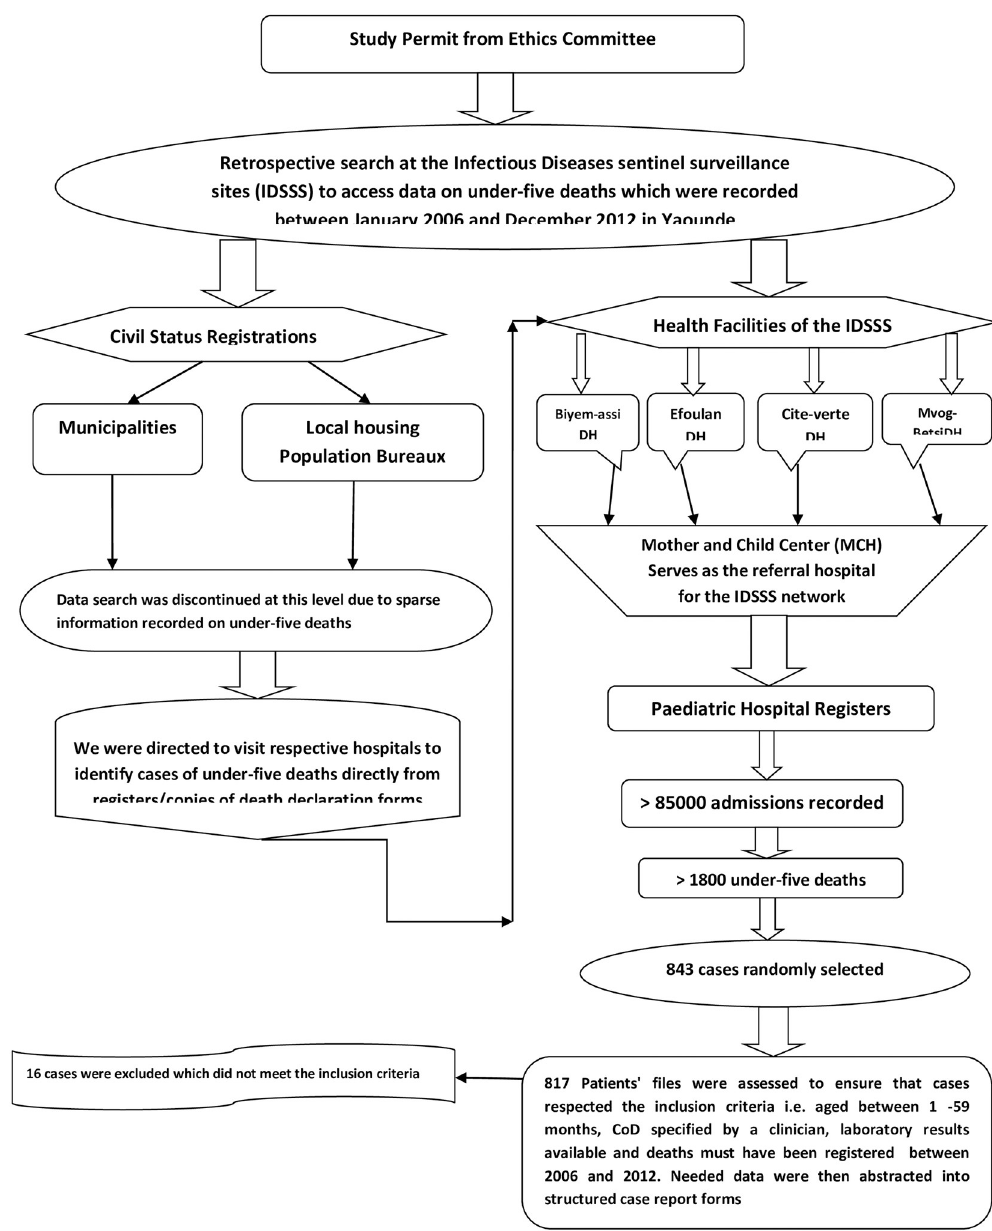
Fig 1. Flow chart on data identification and collection processes. N.B: For the sample size estimation, we assumed that, 18% of study population (630000) were children under-five years old; a = 0.05; power = 80%, and proportion of death cases with missing data on cause-specific death = 10%. Using the computer-based Creative Research Systems Survey software (http://www.surveysystem.com), we assumed a desired confidence level of 95% and a confidence interval of 4% units on each side; the estimated sample size for this study is 600 deaths. Therefore, a minimum of 660 cases of death in children aged 29days to 59 months was targeted as the sample size in this study. DH = District Hospital; ICD-10-CM = the International Classification of Diseases and Clinical Modifications 10th